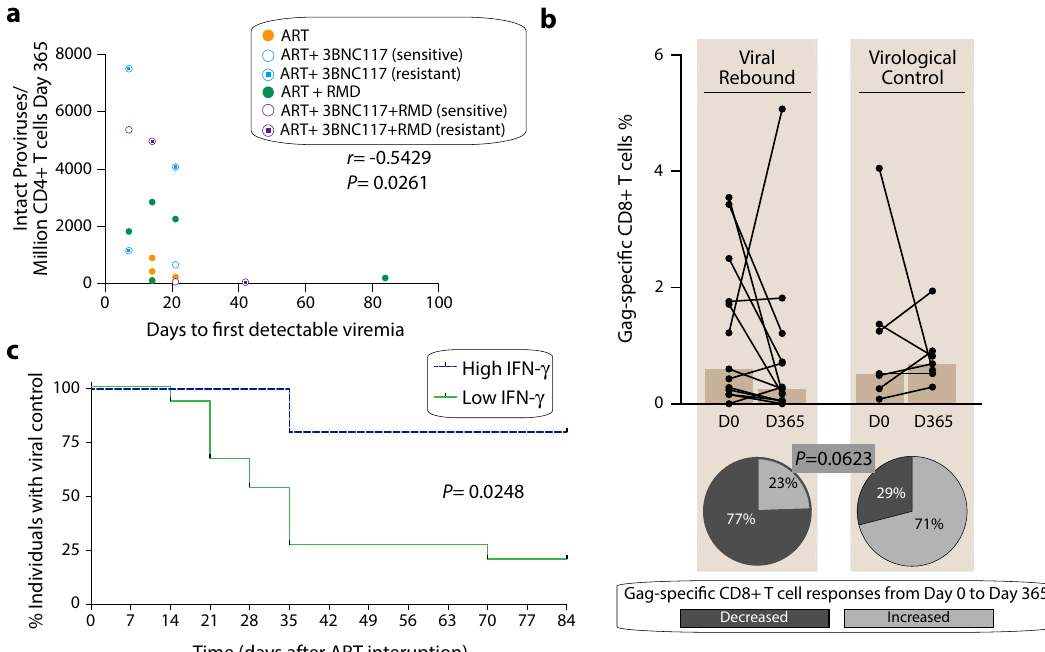
Fig. 4 | Correlation of ART-free virological control. a Correlation between the number of intact proviruses detected per million of CD4 + T cells detected after 365days of ART (immediately preceding ATI) and days to fi rst detectable viremia during ATI( n =17).Individual dots are color-coded according to the groups. R and P -values were calculated using two-sided Spearman rank-order correlation. b Frequency of Gag-speci fi c CD8 + T cell and percentage of individuals showing a decreased or increased frequency of Gag-speci fi c CD8 + T cell responses (%) from